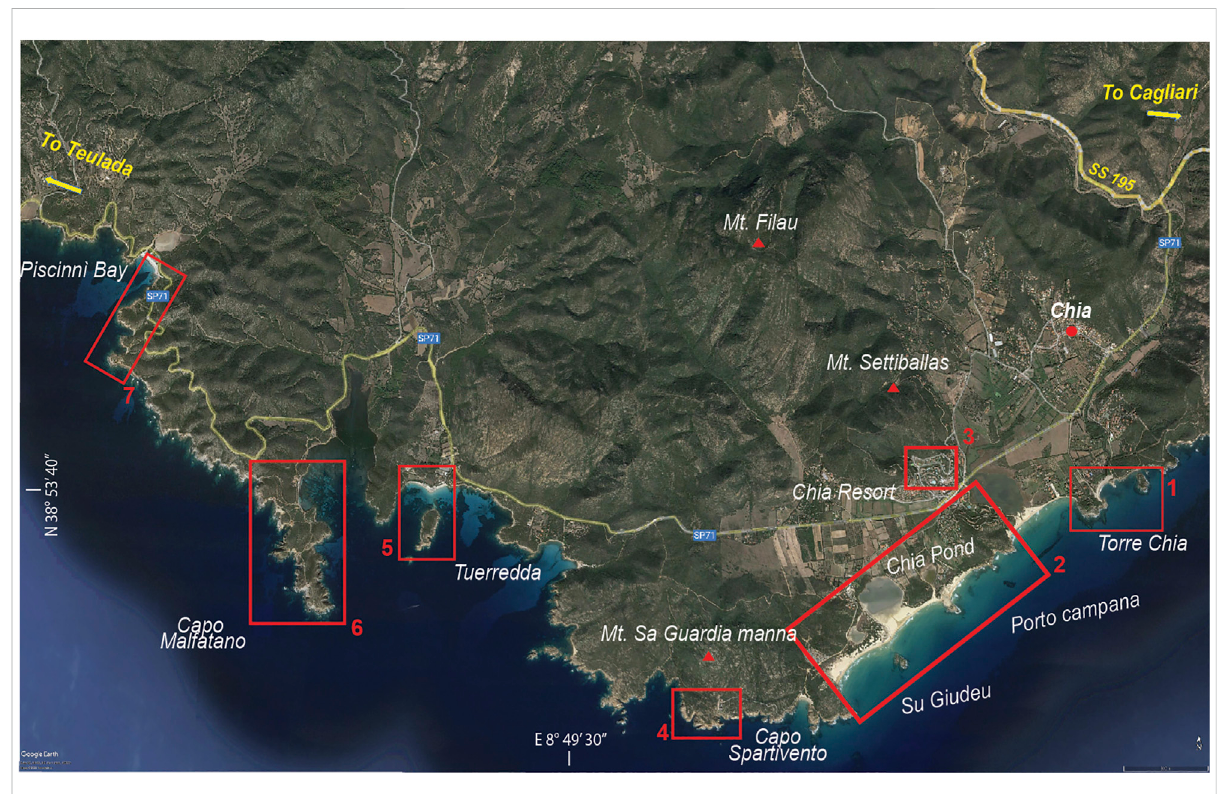
FIGURE 2 Satellite overview (from Google Earth) of the suggested stops for the geological, archaeological, and naturalistic